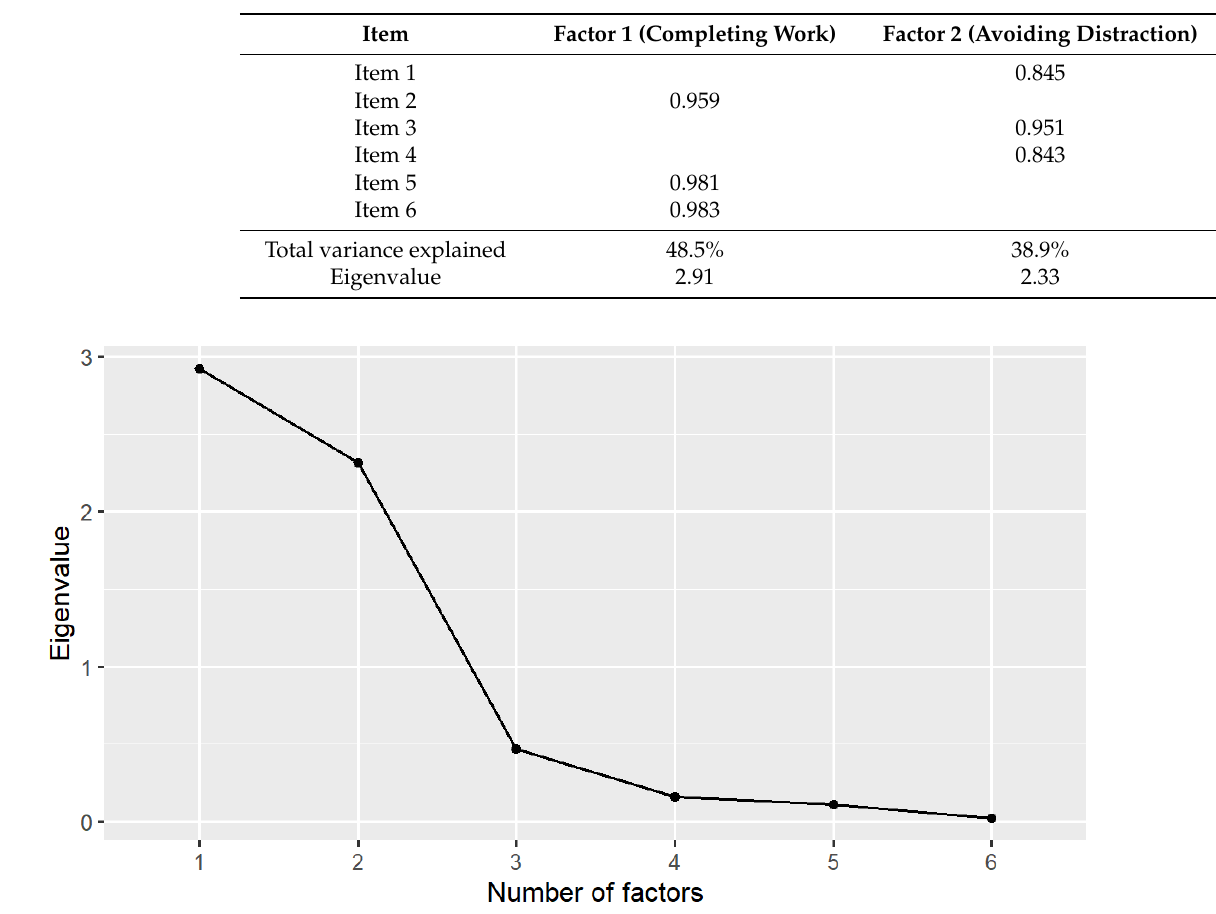
Table 2. Factor loadings of the CSPS-6 (principal components analysis extraction and Varimax rotation methods).